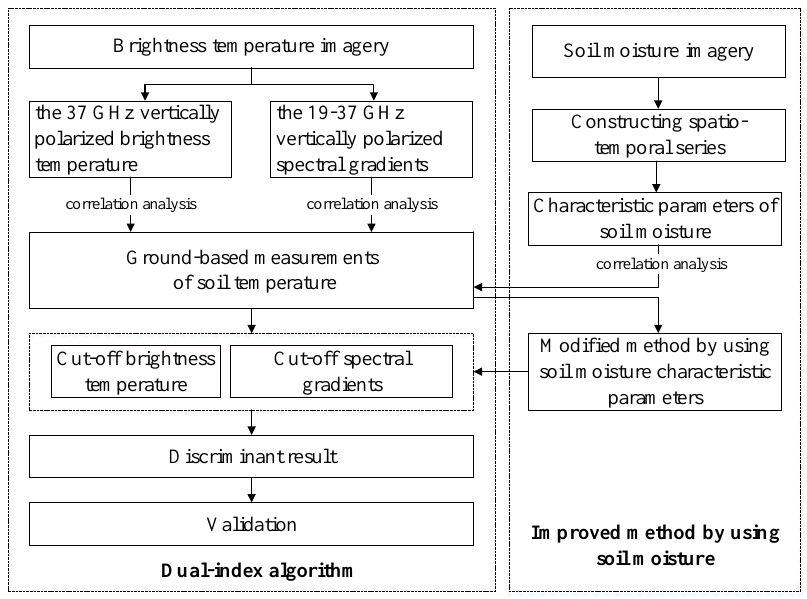
Figure 1. The overall framework of the improved algorithm proposed in this study.